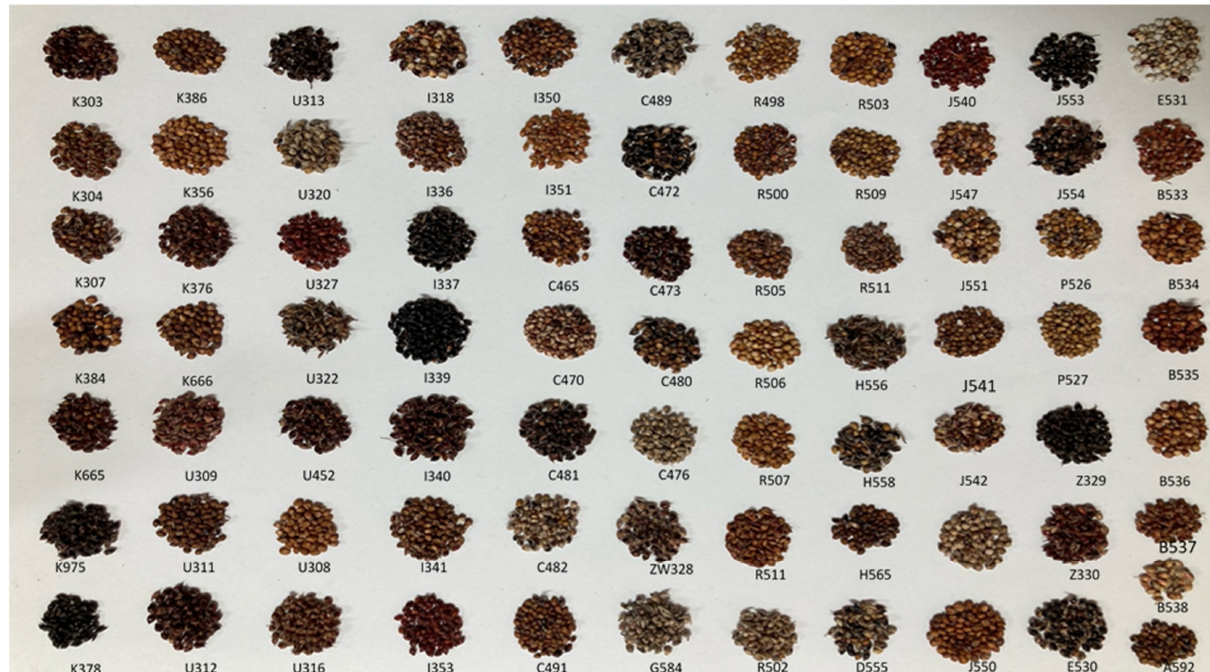
Figure 1. Diversity in S. bicolor accessions with different origins based on seed characteristics.